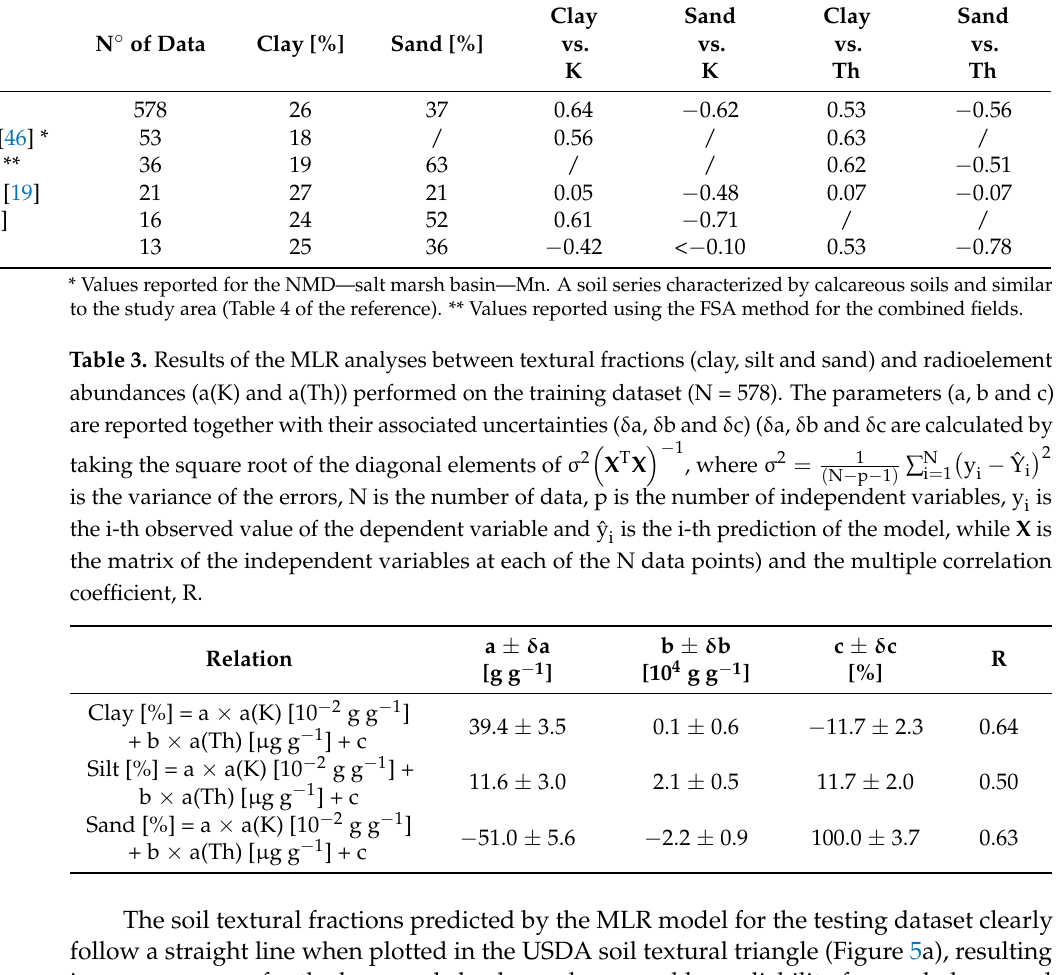
r Sand Clay Sand Clay vs. vs. vs. vs. Th K K